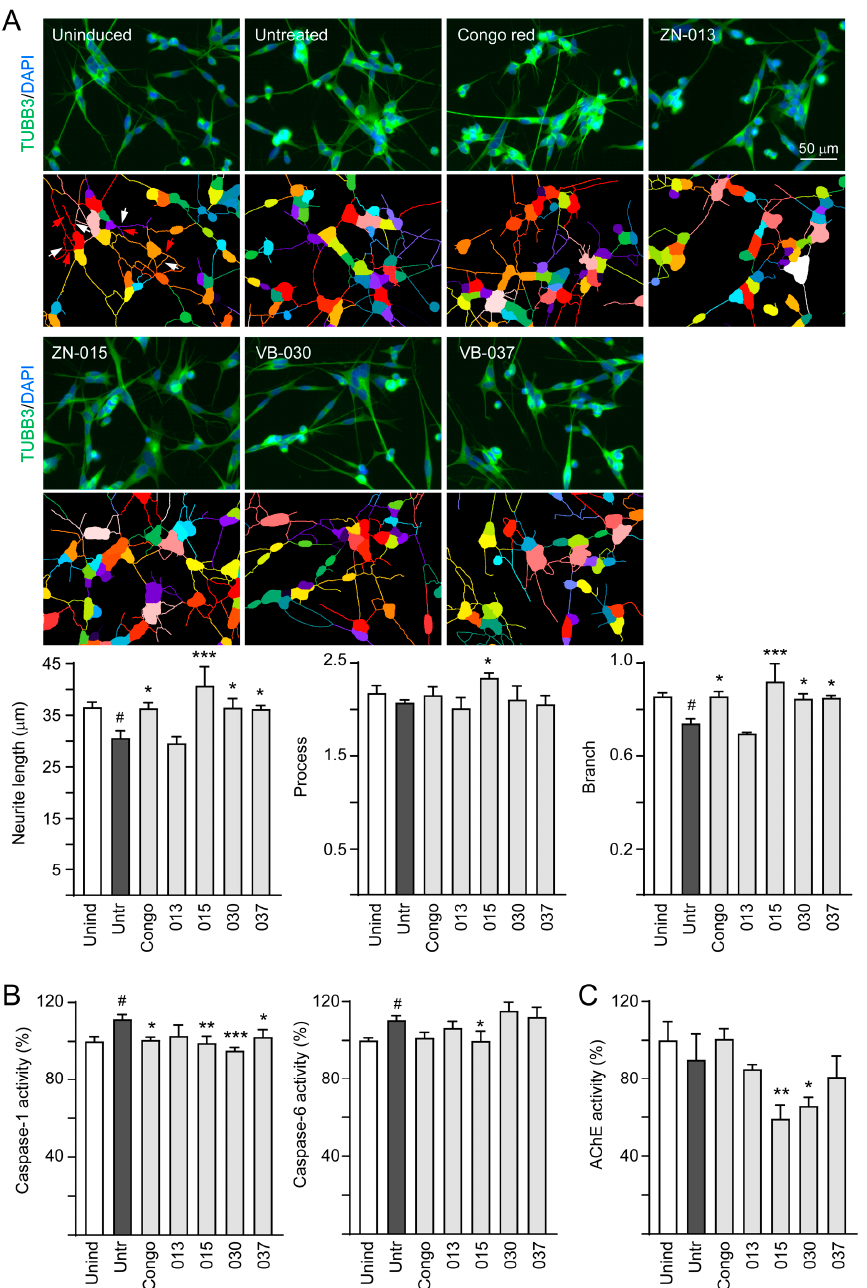
Figure 4. Neuroprotective effects of ZN/VB compounds in Δ K280 Tau RD -DsRed SH-SY5Y cells. ( A ) High-content assessment of neurite outgrowth (TUBB3 stain, green) ( n = 3). The relative length, process, and branch of neurite of uninduced cells was normalized (100%). Nuclei were counterstained with DAPI (blue). The multi-colored mask was applied on segmented fluorescence images to assign the outgrowth of a cell body for quantification. Different colors outline different neurons and their respective neurite outgrowth. The arrows indicated in the uninduced photo are process (red) and branch (white). The total length, process and branch of neurite were calculated. ( B ) Caspase-1, caspase-6, and ( C ) AChE activity assessments ( n = 3). The relative caspase-1/caspase-6/AChE activity of uninduced cells (Dox-) was normalized (100%). p values: comparisons between induced (Dox+) vs. uninduced (Dox-) cells ( # : p < 0.05), or compound-treated vs. untreated (induced) cells (*: p < 0.05, **: p < 0.01, ***: p < 0.001) (one-way ANOVA with a post hoc Tukey